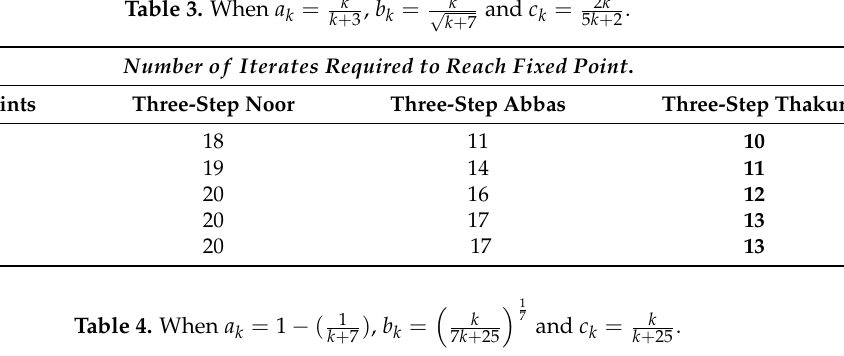
(cid:16) (cid:17) 1 7 and c k ) , b = = k . k k k + 7 k + 25 7 k + 25